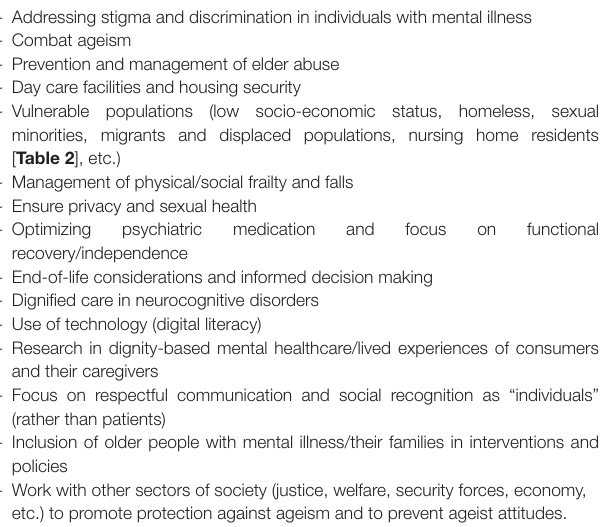
TABLE 1 | General areas of dignity-based mental health interventions.